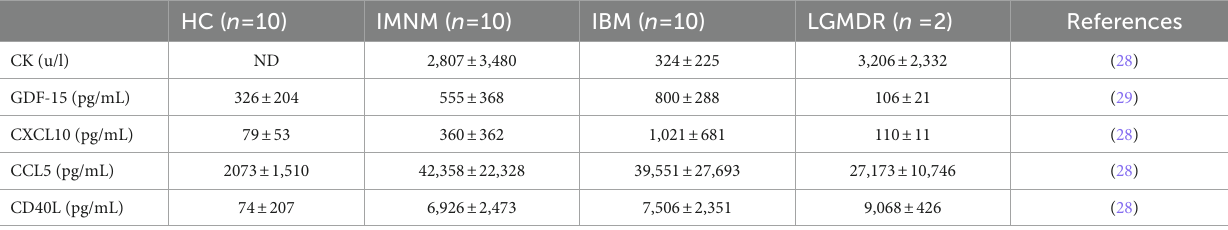
TABLE 1 Serum biomarker levels in patients.